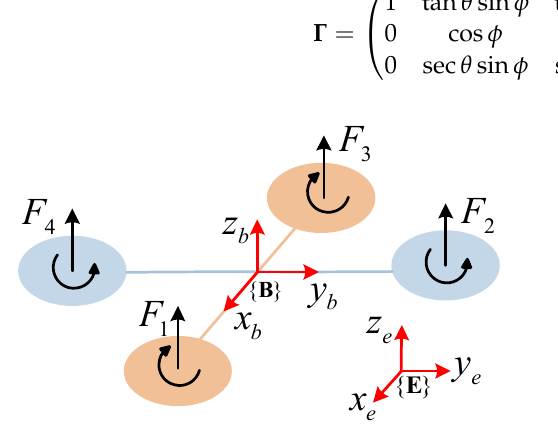
Figure 1. Illustration of quadrotor sketch.